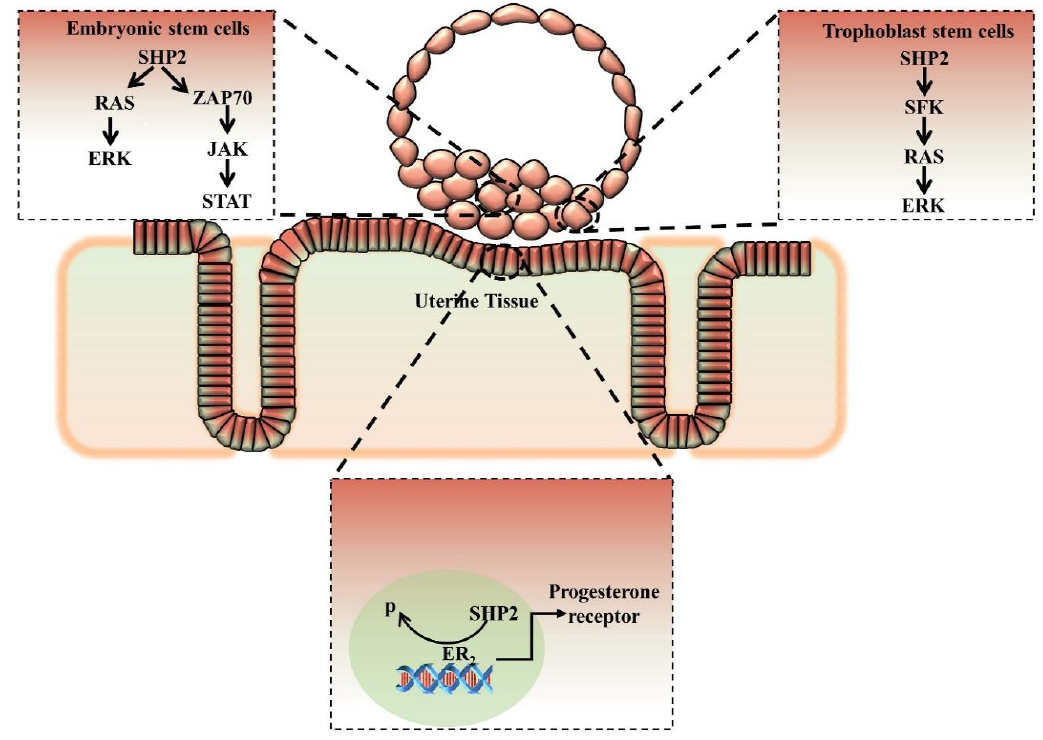
Figure 5. Schematic representation of embryo implantation. SHP2 is expressed in inner mass cells and outer trophoblast cells. SHP2 regulates FGF4 signaling in trophoblast stem cells proliferation and differentiation, and also participates in invasion of the mother uterus. Uterine SHP2 is nuclear-localized and regulates ER-α transcription of progesterone. SHP2 inhibition or knockout either from embryo or uterus completely blocks embryo implantation.